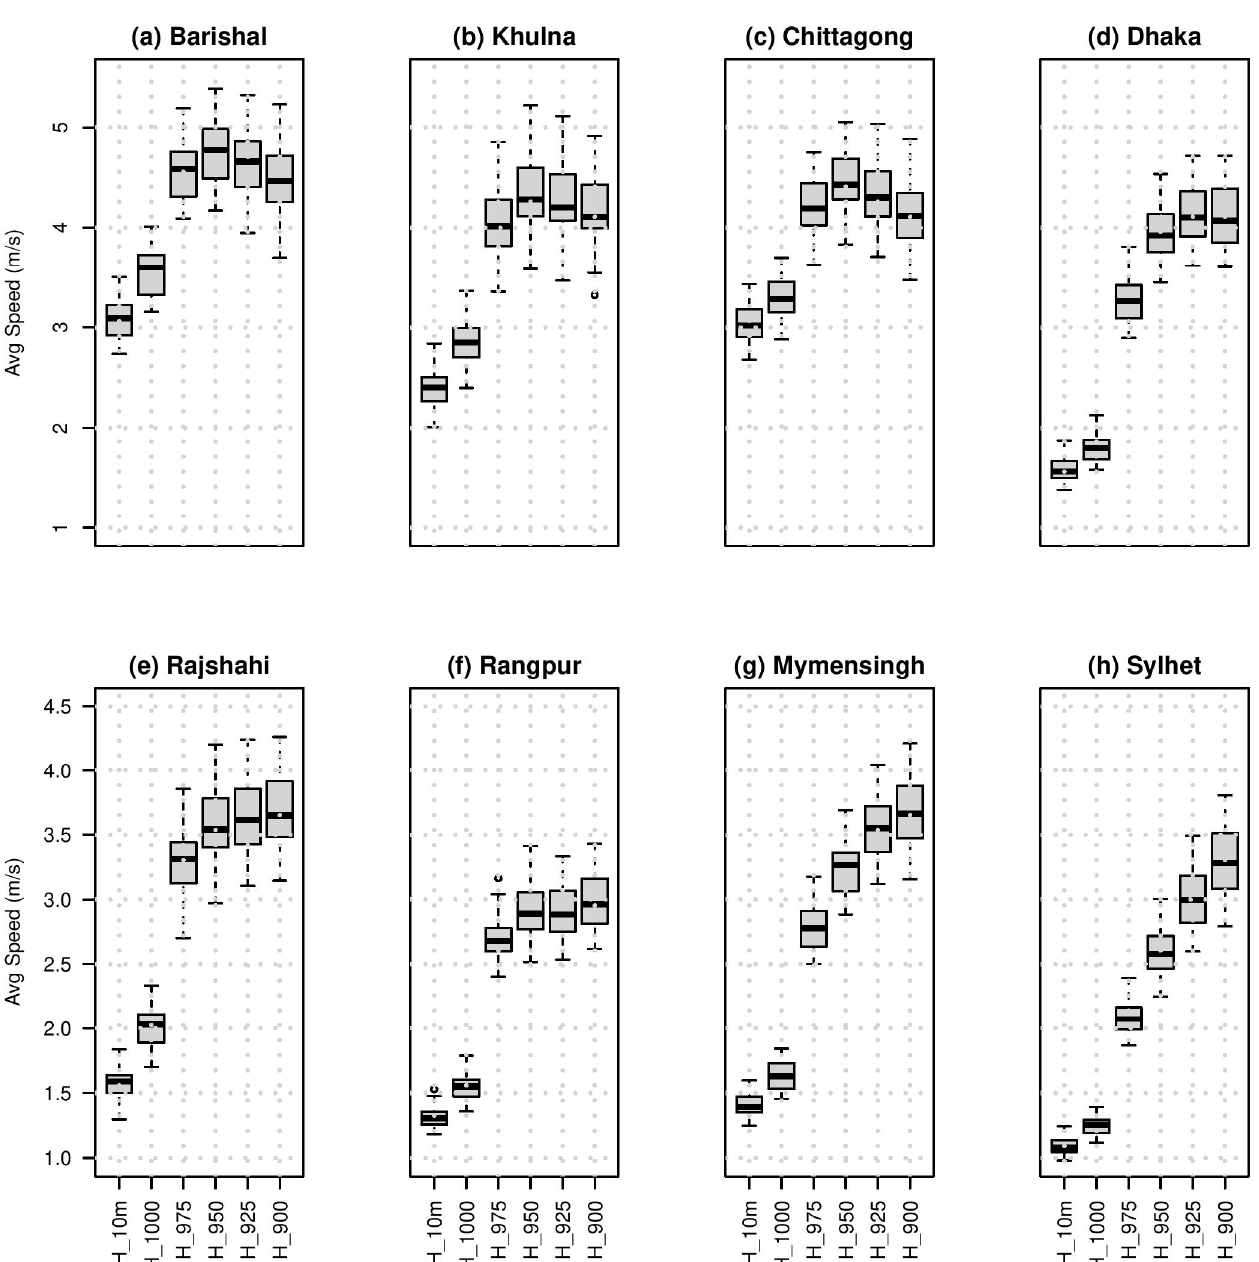
Figure 2. Descriptive statistics of wind speed (m/s) at 10 m and pressure levels: 1000, 975, 950, and 925 hPa for southern (top panels) and northern region (bottom panels) averaged from 1979 to 2018 with a climatic base of 20 years (1979 to 2000).